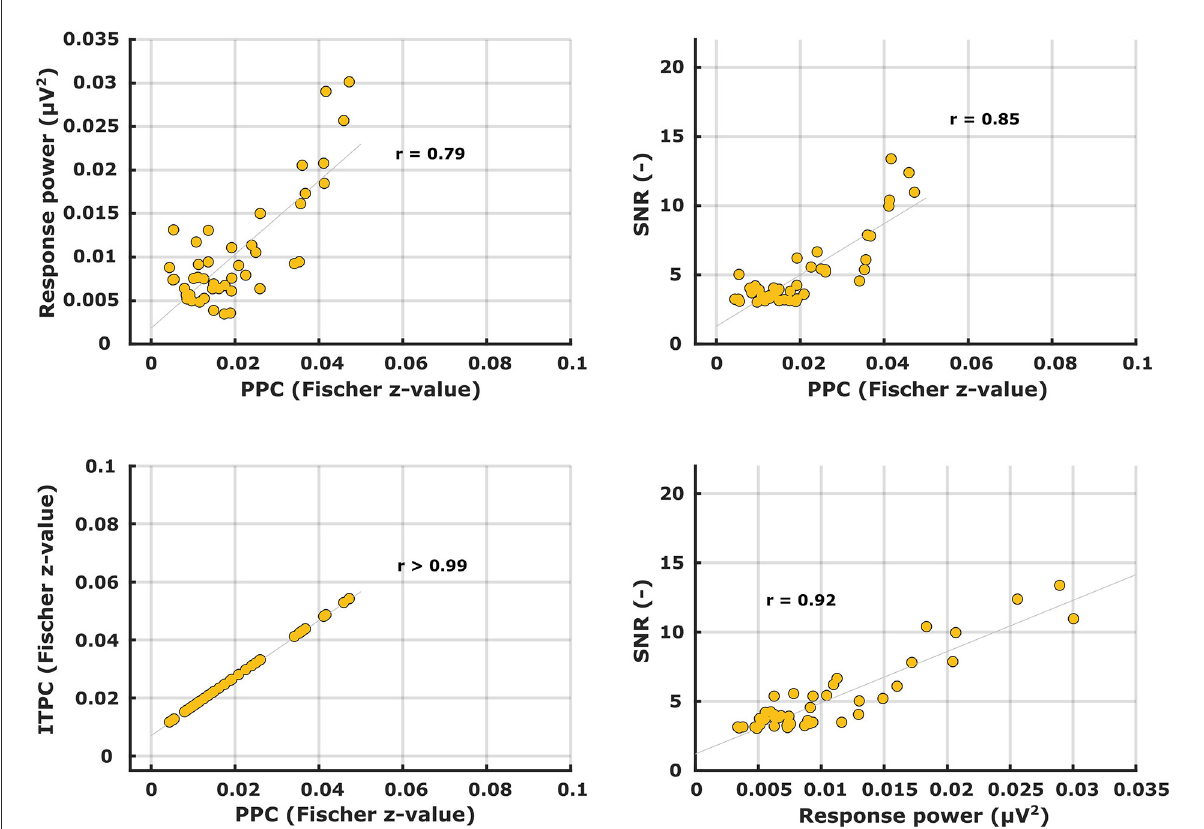
FIGURE8 Scatter plots between different electrophysiological metrics for syllabic-like TEMPEST neural responses in the left hemispheric